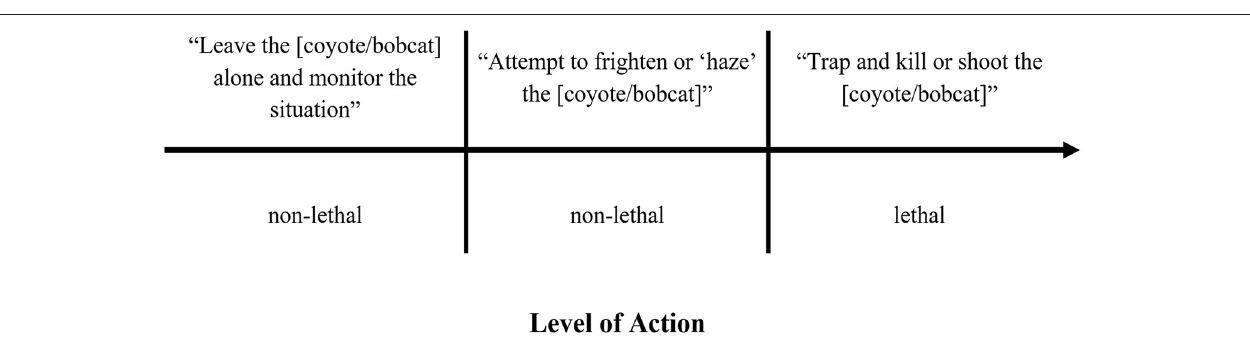
FIGURE 2 | Predator control options for responding to the carnivore scenarios